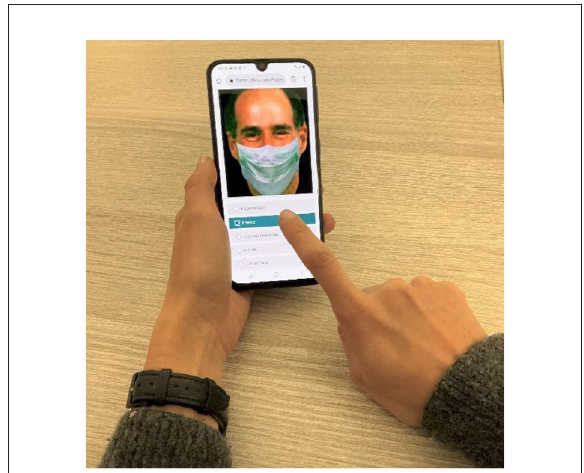
FIGURE2 Experimental procedure. We asked participants to identify the correct facial emotion by choosing between five possible randomized options: happy, sad, fearful, angry, and neutral. Each face was displayed on the screen of personal smartphones for as long as it took to respond by holding an index finger against the touch screen. The study obtained face images with permission from the ER-40 color emotional stimuli public database (30,